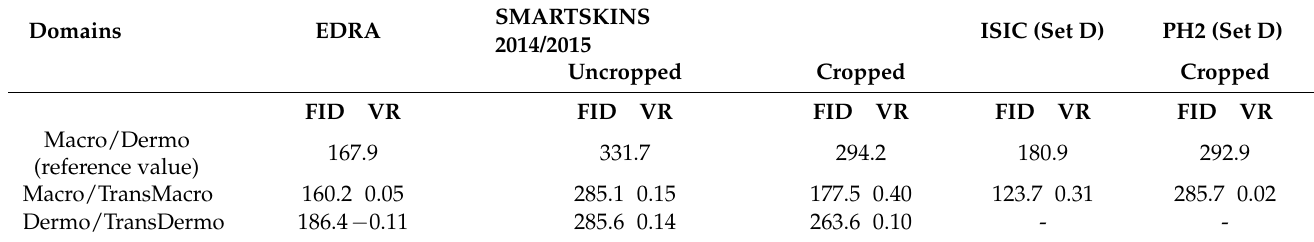
Table 3. Fréchet Inception Distance (FID) and Variation Ratio (VR) results in the test subsets of EDRA, SMARTSKINS 2014/2015, PH2 and